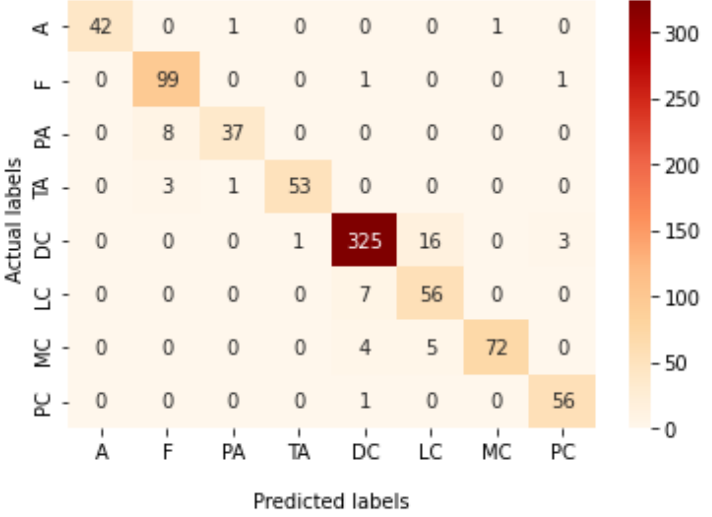
Figure 22. Confusion matrix of Xception model in magnification-independent multi-classification experiment.